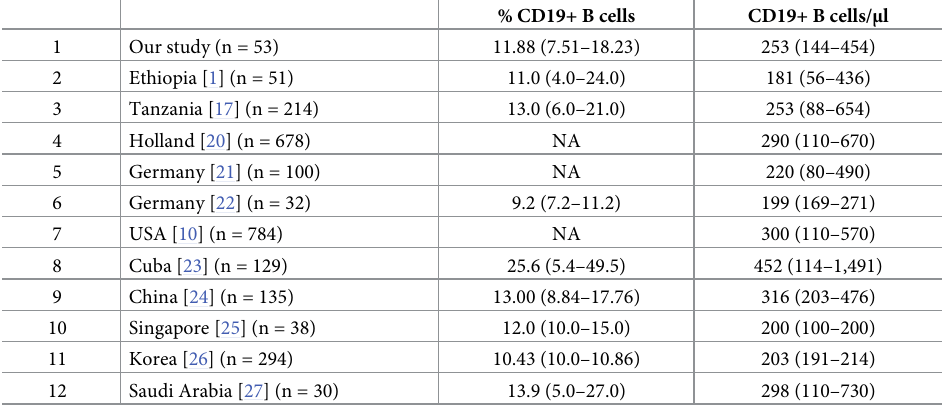
Table 4. Medians (10 th and 90 th percentiles) of proportions and absolute counts of B cells in study participants from different countries in the age range of 18 to 40